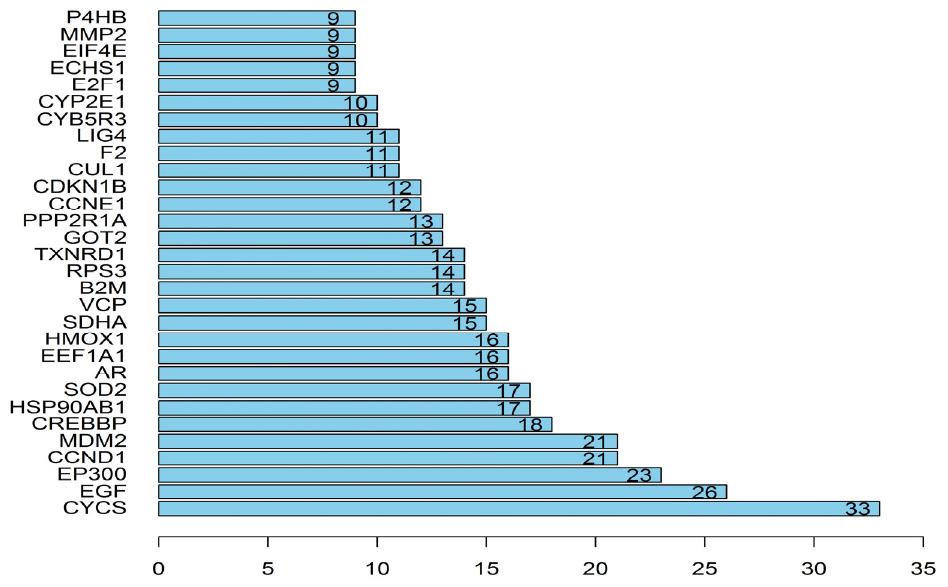
Figure 6. Degrees of freedom of the target.